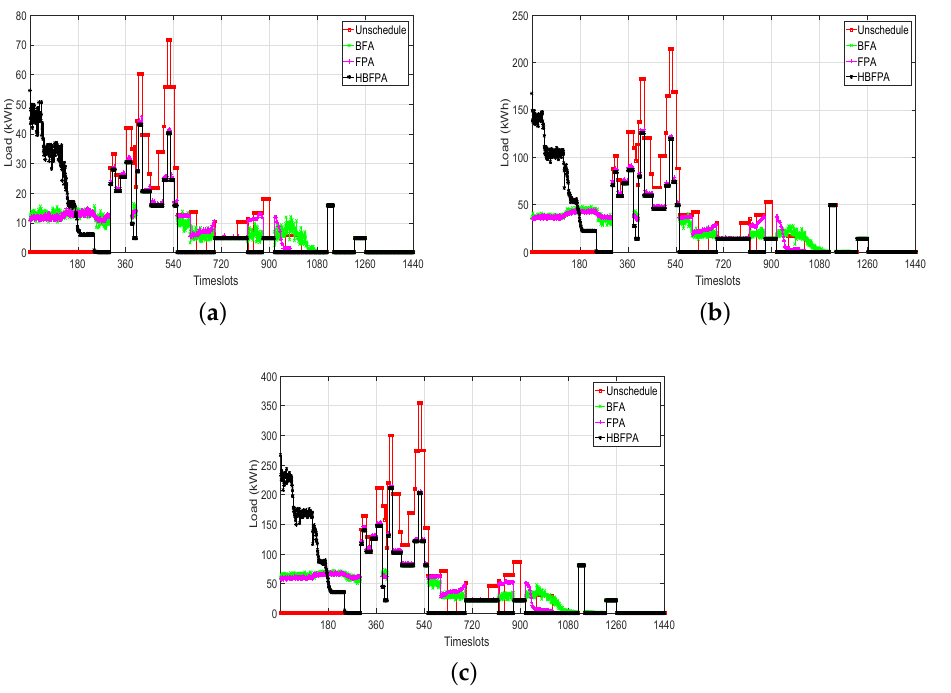
Figure 8. Load for multiple homes: (10, 30 and 50) using critical peak pricing. ( a ) load using operational time interval of 1 min for 10 homes; ( b ) load using operational time interval of 1 min for 30 homes; ( c ) load using operational time interval of 1 min for 50